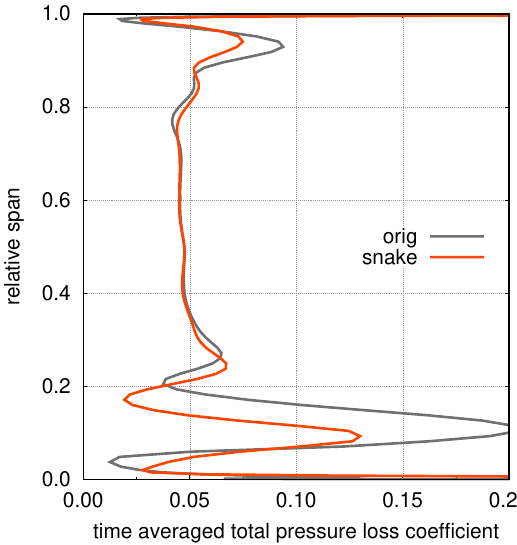
Figure 10. Time averaged rotor